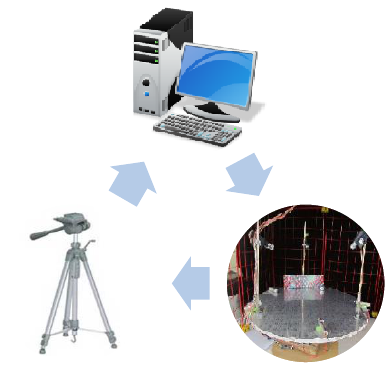
Figure 2 - general processes of proposed system